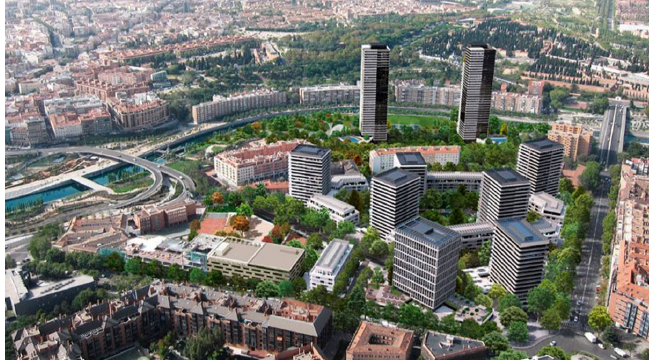
Figure 4. Recreation of the Mahou-Vicente Calderón project (2014) [42]. Copyright 2014 Laura Sánchez Carrasco and Rubio